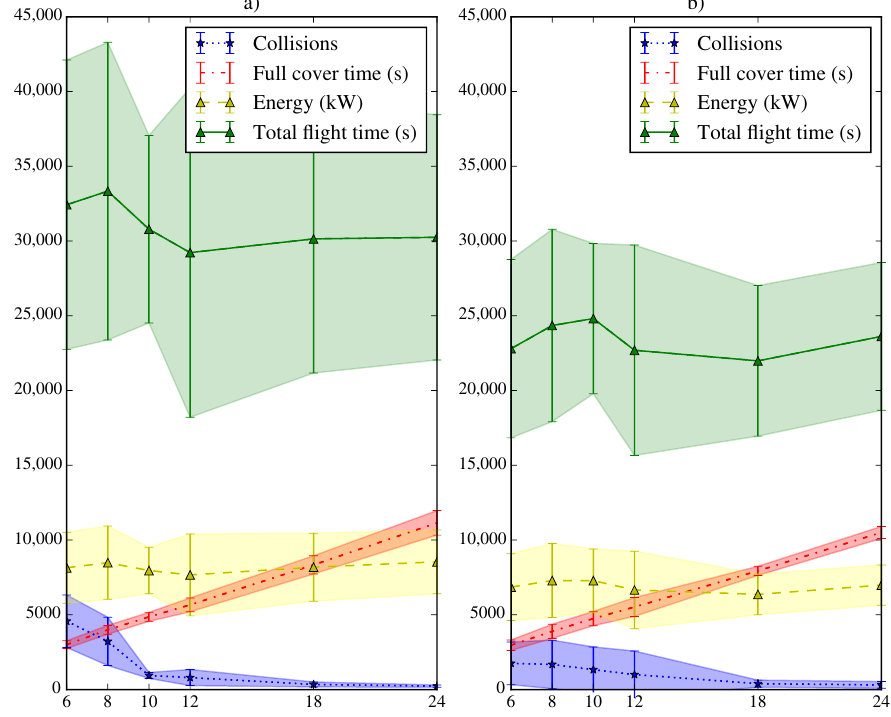
Figure 13. Results of the SLABE ( a ) and SEPHE ( b ) behavior simulations performed on 50 random hard maps. In each simulation, a random start position has been chosen among all feasible locations. Six different take-off time intervals (6, 8, 10, 12, 18, and 24 s) have been tested for each map. The average and standard deviation of the number of collisions, the time required to achieve 95% coverage, the energy consumed by the swarm and the total flight time are